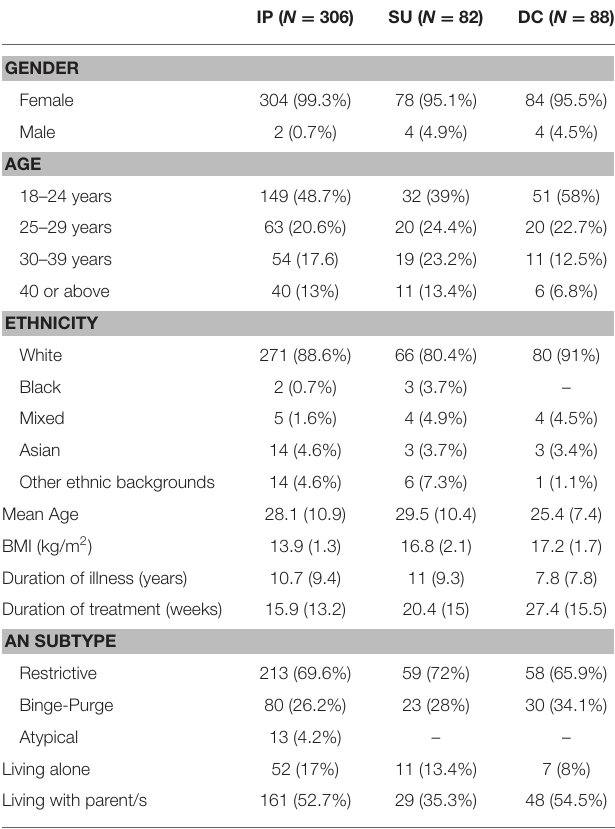
TABLE 1 | Sociodemographic and clinical characteristics at